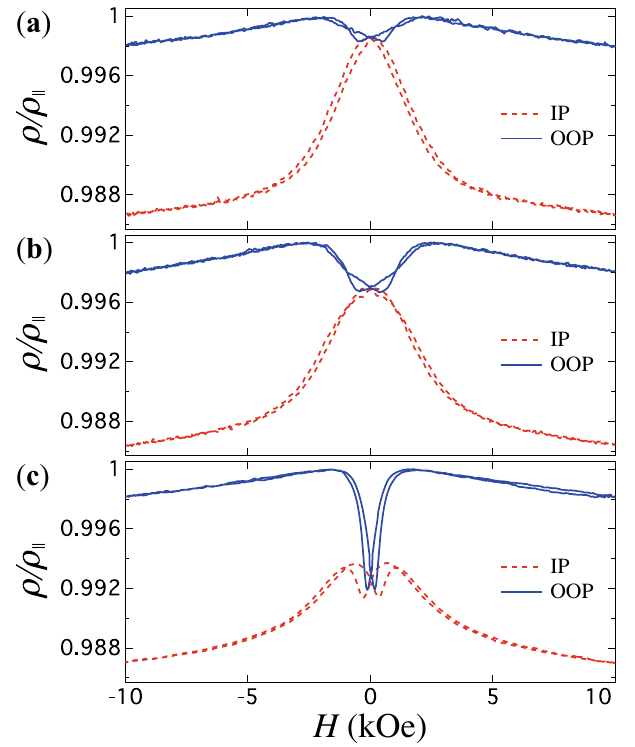
Figure 5. Anisotropic magnetoresistance curves measured with the external field applied in the OOP (continuous lines) and IP (dashed lines) directions to the plane of the porous template for two CNW networks with NWs diameter of ( a ) 105 nm, ( b ) 230 nm and ( c ) for a CNT network with NTs outer diameter of 230 nm.